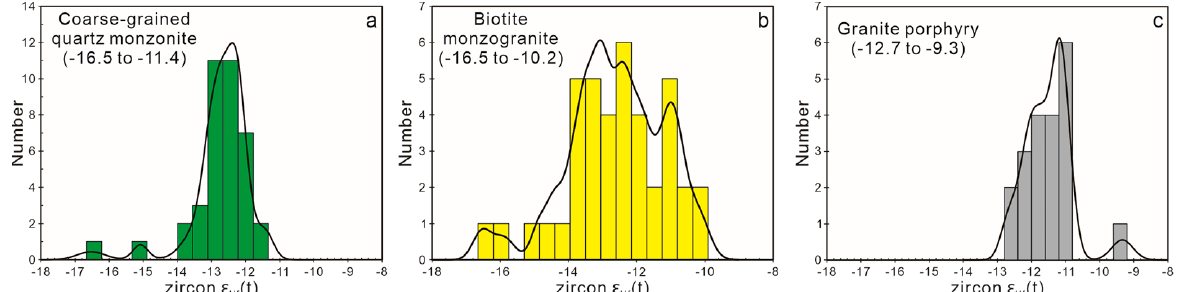
Figure 8. Histograms of the zircon ε Hf (t) values of the ( a ) coarse-grained quartz monzonite, ( b ) biotite monzogranite, and ( c ) granite porphyry in the Yushulinzi pluton in the Liaodong Peninsula. The zircon 176 Hf/ 177 Hf ratios of the coarse-grained quartz monzonite (08JF76 and 78), biotite monzogranites (08JF69 and 74), and granite porphyry (08JF76) in the Yushulinzi plu- ton are 0.282238–0.282379, 0.282233–0.282416, and 0.282342–0.282440, respectively, which are consistent within the analytical errors, and their corresponding ε Hf (t) values and Hf model ages are generally consistent as well (Figure 8). The zircon grains extracted from the samples of different rock types have ε Hf (t) values of − 16.5 to − 9.3, with corresponding single-stage Hf model ages (T DM ) of 1232–1529 Ma and two-stage Hf model ages (T 2DM ) of 2456–3098 Ma (Table S5). The coarse-grained quartz monzonite has δ 18 O values of 5.7–6.7‰ (Table